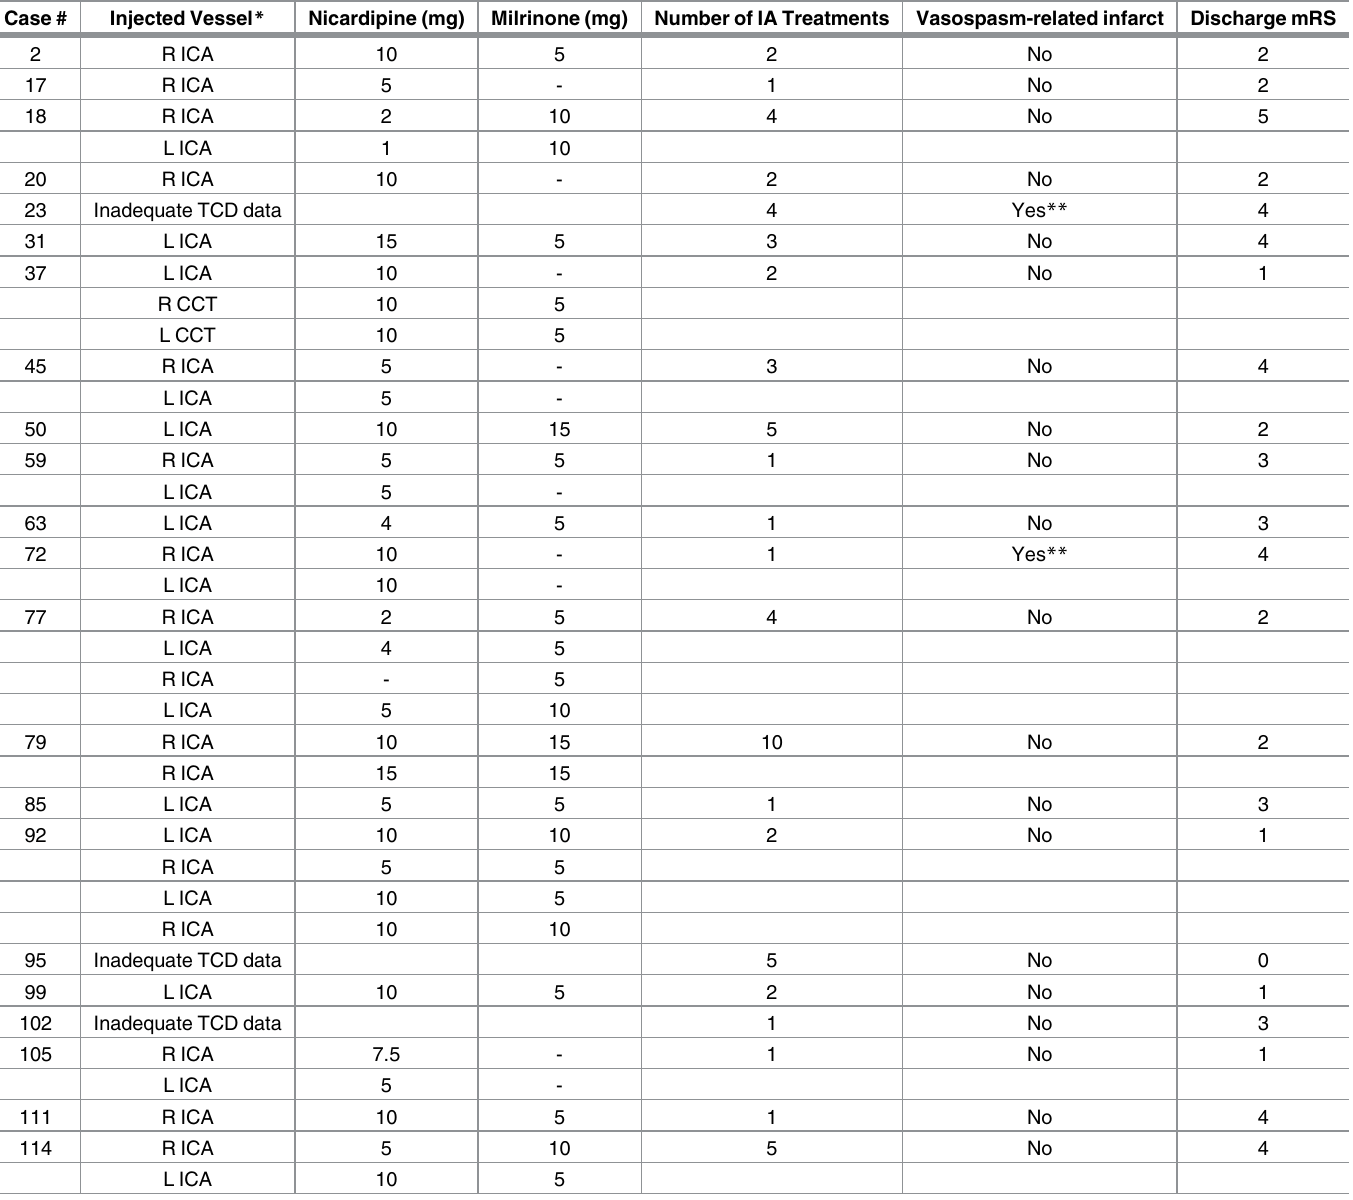
Table 3. Details of the IA